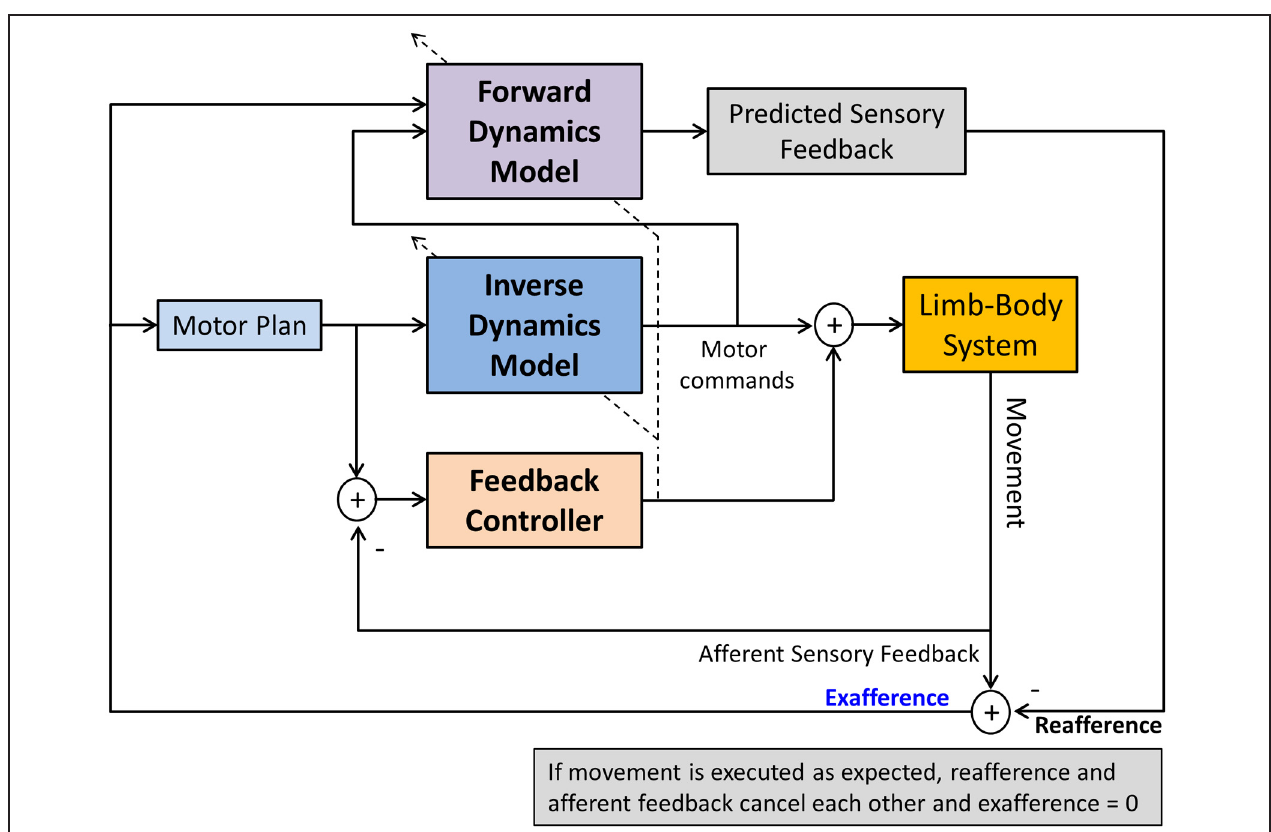
FIGURE 4 | A computational model of voluntary sensorimotor control. Parallel feedback and feedforward mechanisms (inverse dynamics model) shape the motor commands. A feedforward dynamics model generates predicted (expected) sensory feedback based on the specified motor commands. Predicted and afferent sensory feedback are compared (reafference vs. afference) resulting in an exafferent signal. With respect to one’s own movement, this signal indicates how “well” the movement was